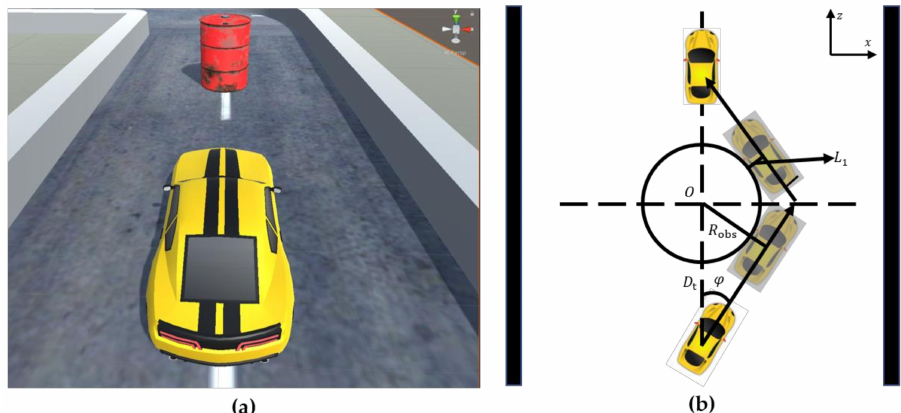
Figure 8. When the direction of the vehicle, speed, the location of the obstacle and the center line of the lane are collinear ( a ). The obstacle is located at the central axis of the road during the actual driving of the vehicle ( b ), is the geometrical schematic diagram of the left figure.